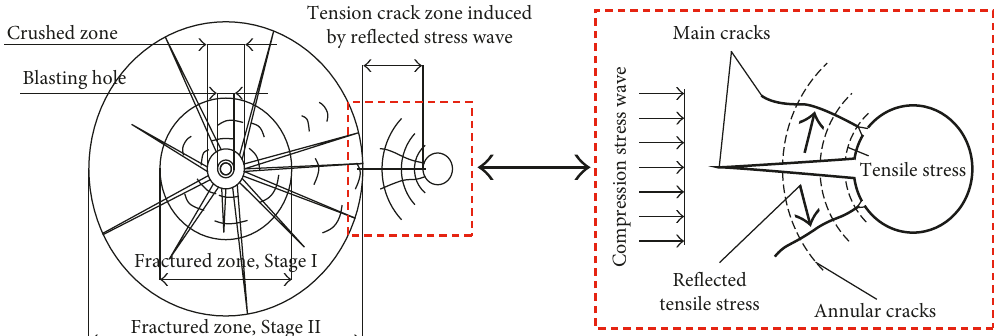
Figure 1: Fracture development characteristics of rock mass with empty holes induced by blasting